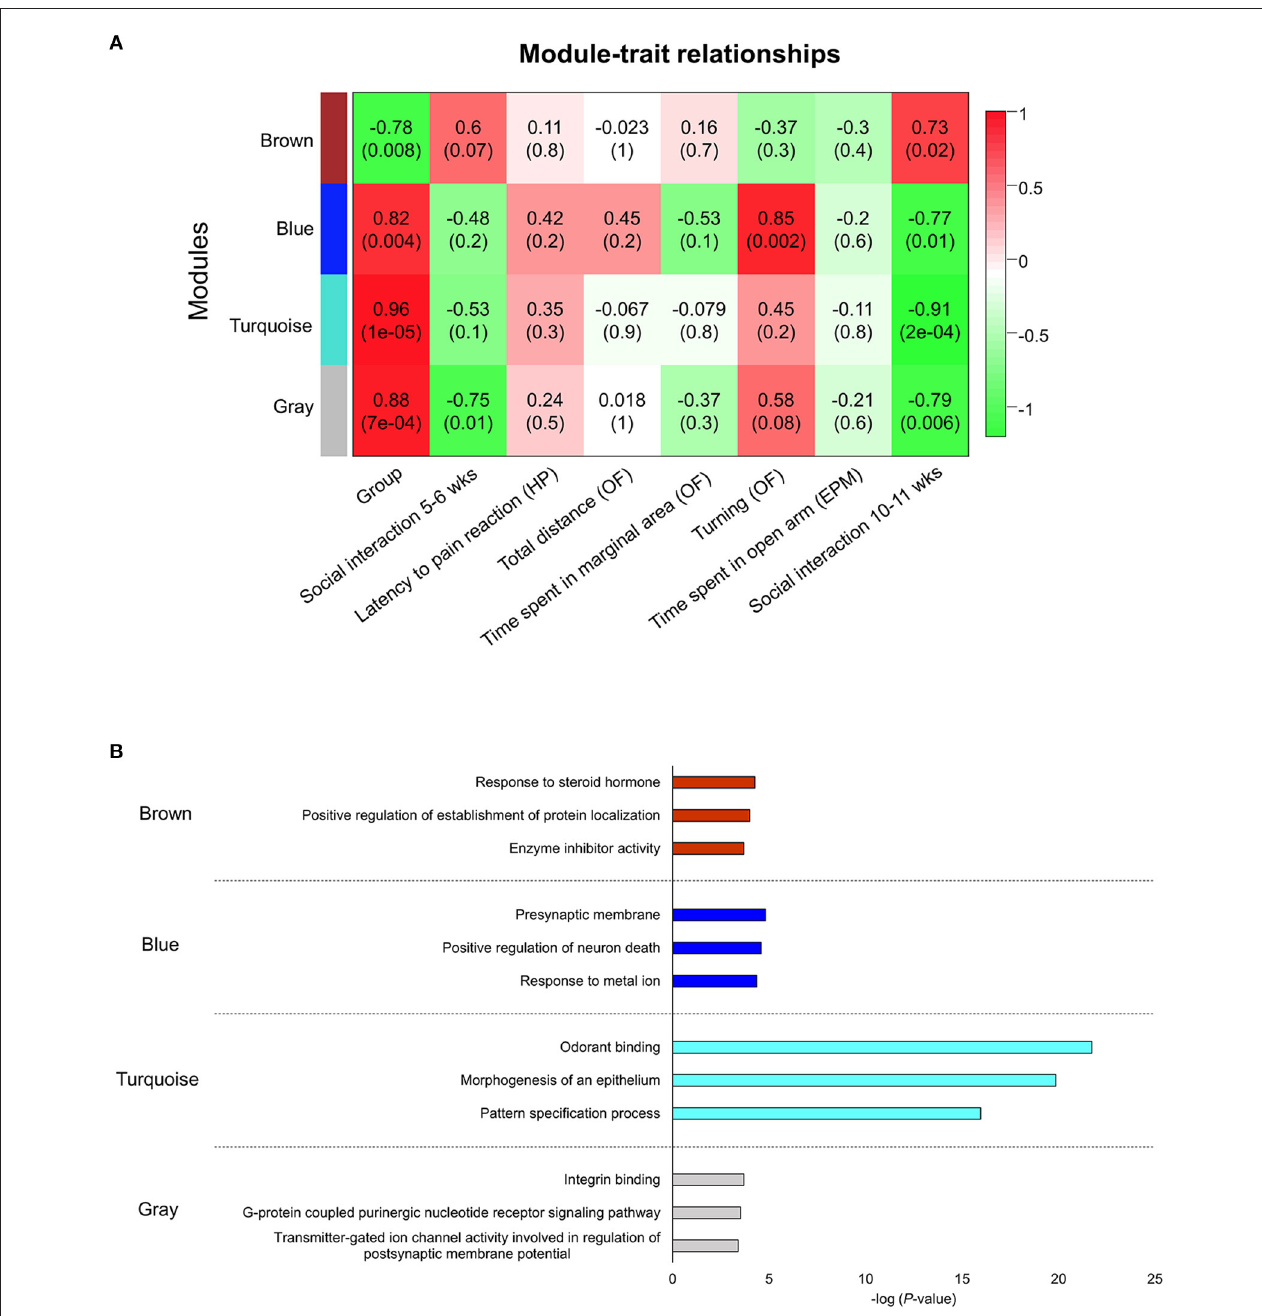
FIGURE 6 | Network construction of co-expressed genes that correlated with performance in the behavioral tests and gene ontology pathway enrichment analysis of each module. (A) Module trait correlation for treatment, social interaction (5–6 weeks of age), latency to flicking, jumping, licking paws (hot plate test), total distance traveled (open field test), time spent in the peripheral area (open field test), turning episodes (open field test), time spent on the open arms (elevated plus maze test), and social interaction (10–11 weeks of age). HP, hot plate test; OF, open field test; EPM, elevated plus maze test. (B) The blue module was the most correlated with turning episodes in the open field test. The turquoise module was the most correlated with social interaction (10–11 weeks of age).